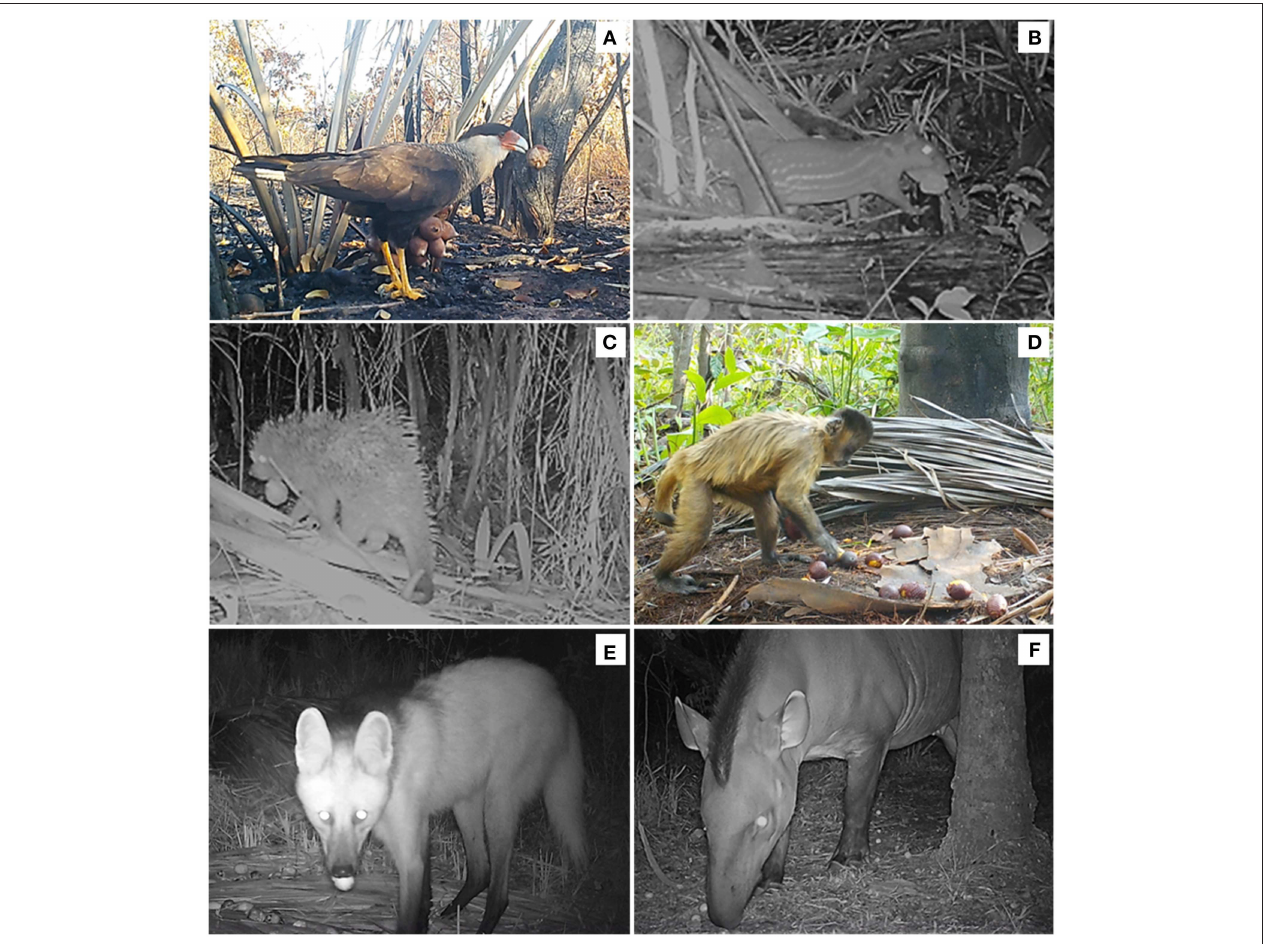
FIGURE 4 | Photographs illustrating examples of secondary external dispersal of palm seeds: (A) Caracara plancus dispersing Attalea barreirensis , (B) Cuniculus paca and (C) Coendou prehensilis dispersing Attalea speciosa ; (D) Sapajus libidinosus and (E) Chrysocyon brachyurus dispersing Mauritia flexuosa ; (F) Tapirus terrestris consuming and potentially dispersing Acrocomia totai . Photographs taken by camera traps.